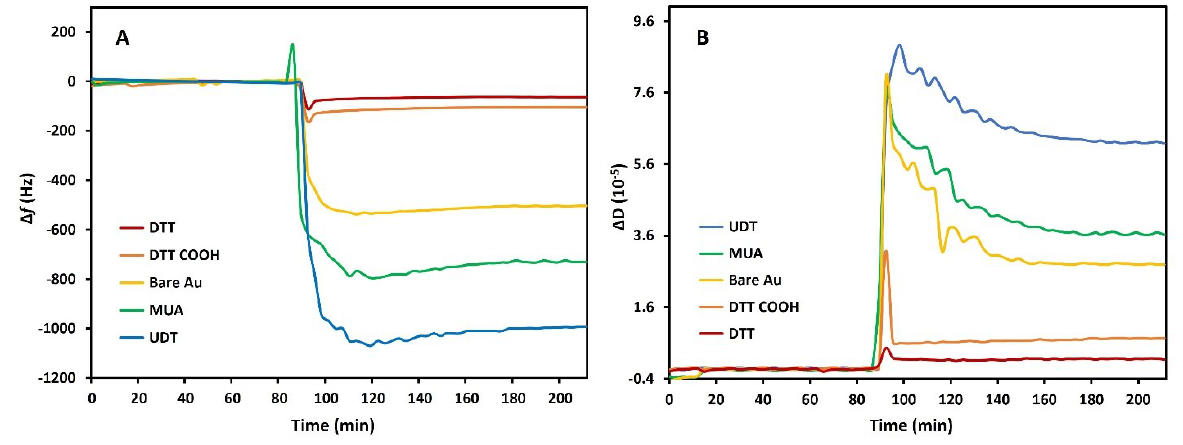
Figure 11. The ( A ) frequency and ( B ) dissipation shifts on gold electrodes with different SAM coatings following exposure to undiluted human serum.